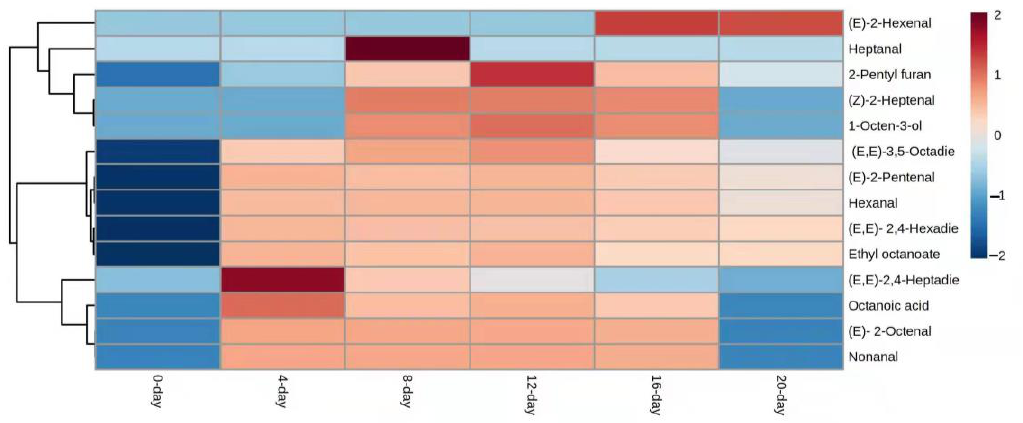
Figure 3. Heatmap visualization of UFAO-derived compounds in model reaction by linolenic acid.